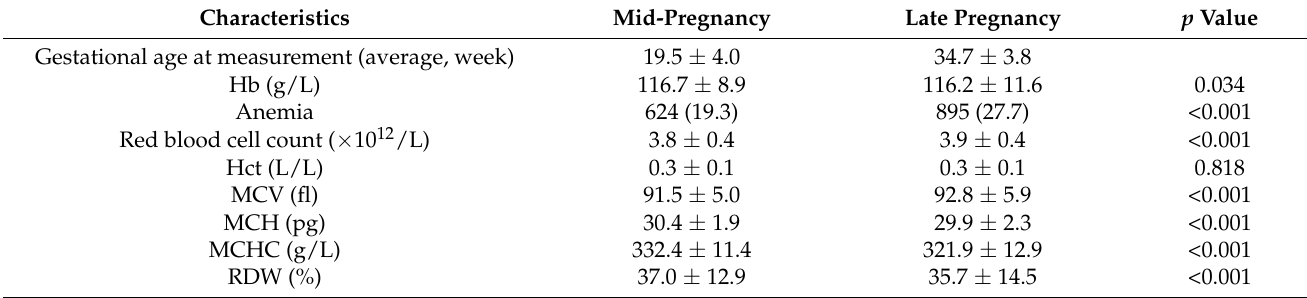
Table 2. Characteristics of hemoglobin and red cell indices † .